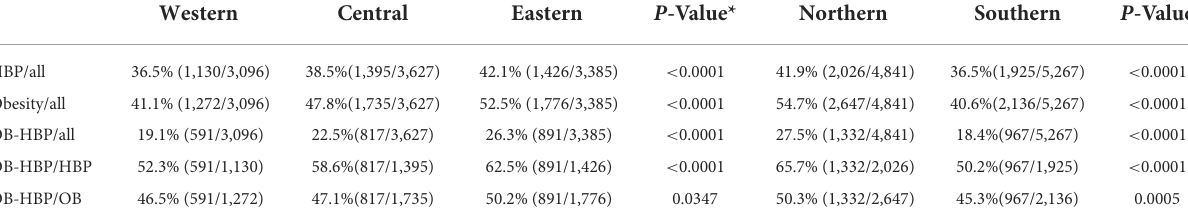
TABLE 4 The prevalence of obesity, hypertension, obesity-related of hypertension among different regions. Western Central Eastern P -Value* Northern